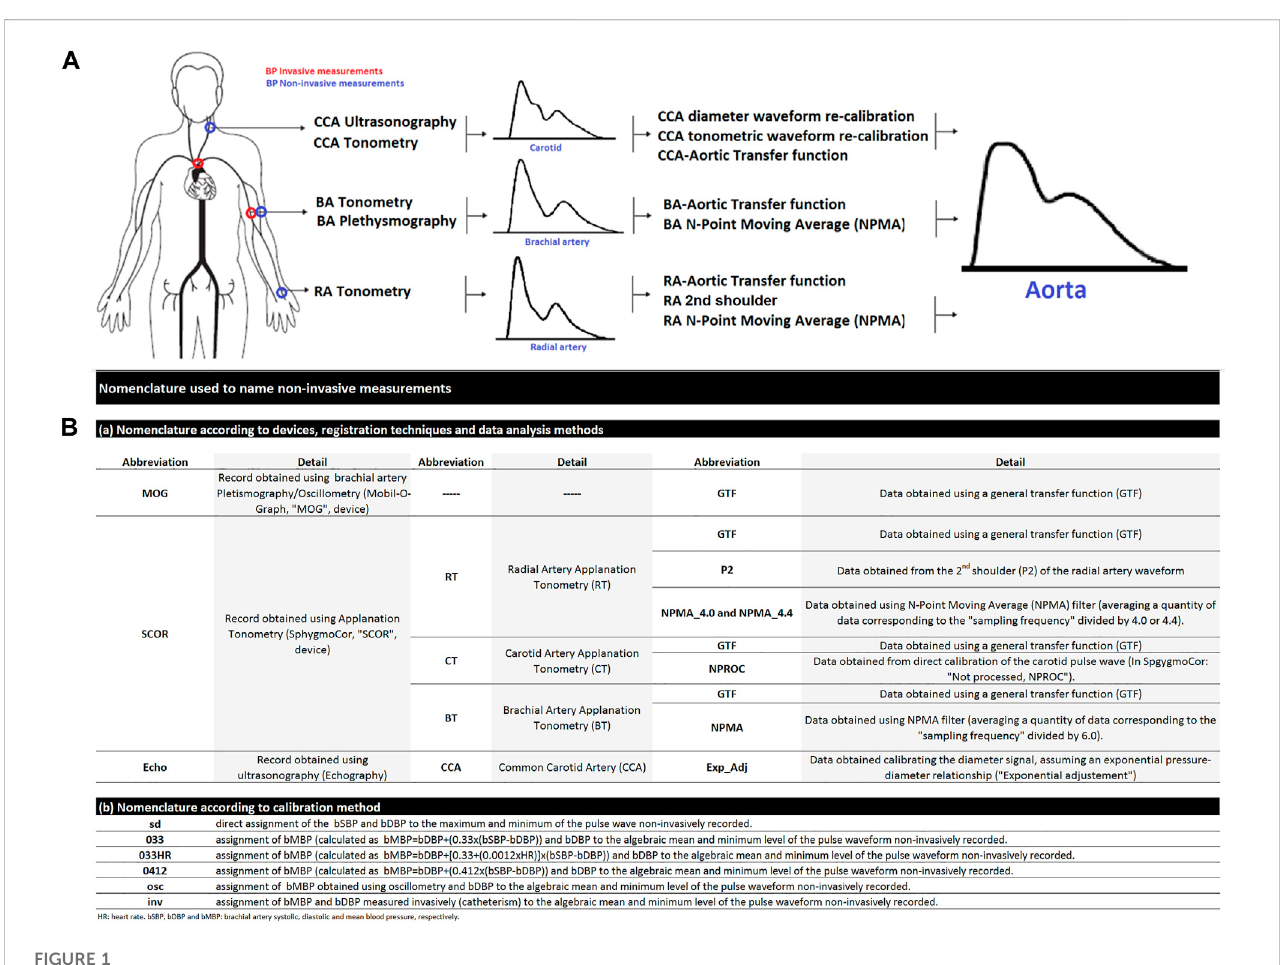
FIGURE 1 (A) : Schematic representation of invasive and non-invasive blood pressure (BP) measurements in the aortic root and brachial artery (A). CCA, common carotid artery. BA, brachial artery. RA, radial artery. In the (B) : nomenclature used to designate non-invasive derived variables.